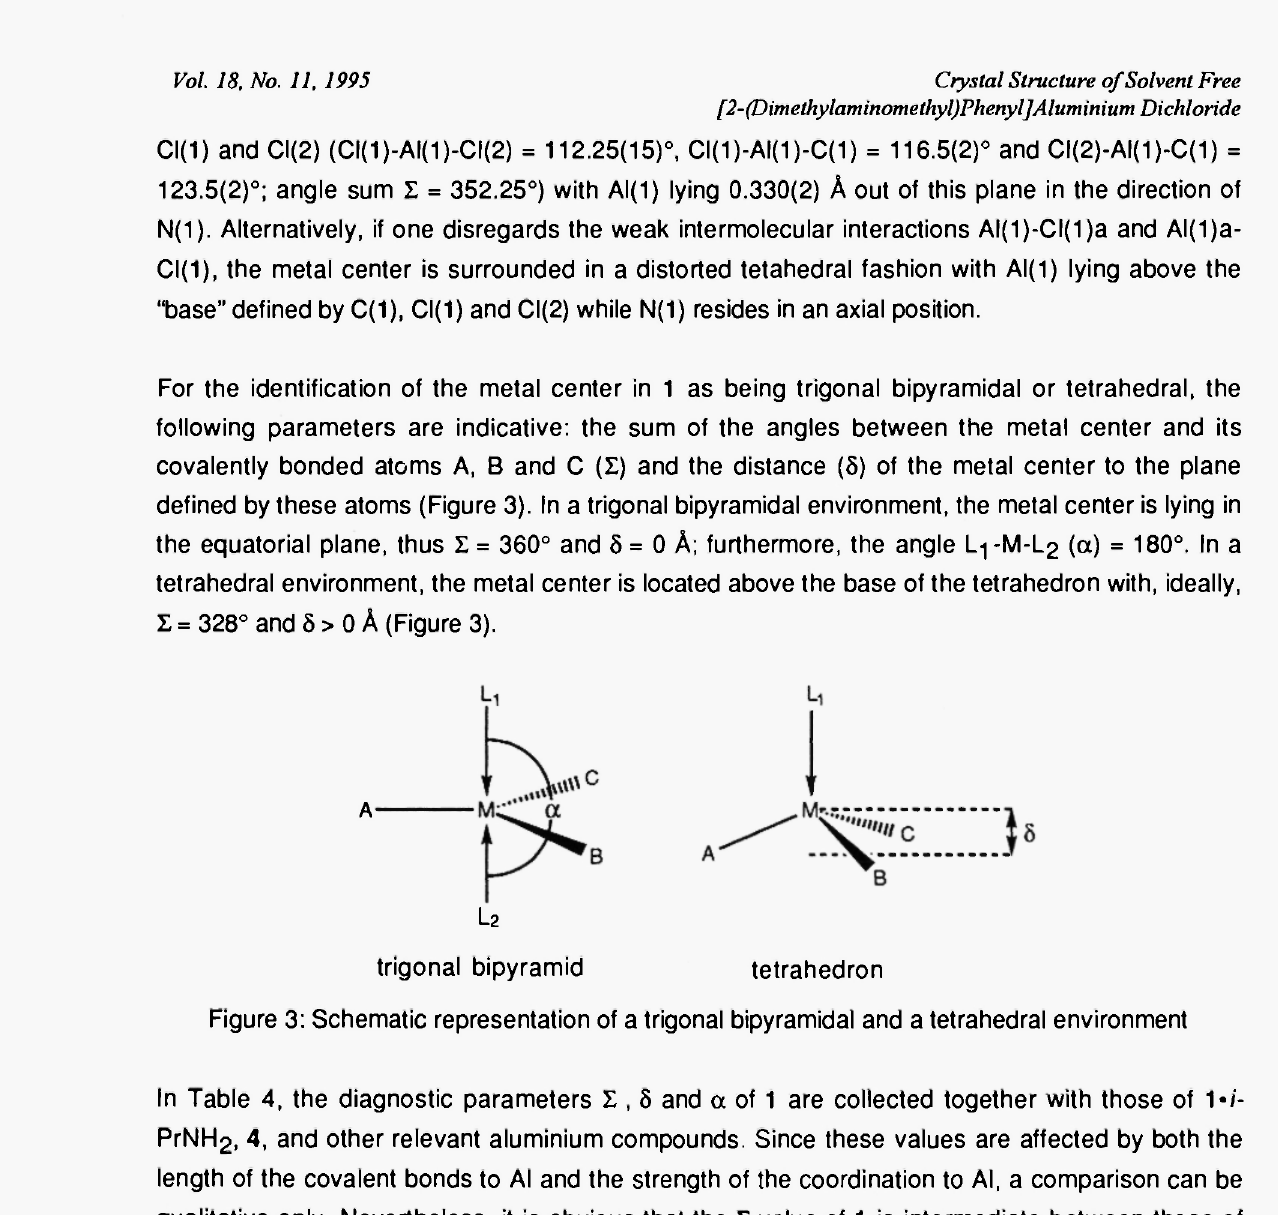
Figure 3: Schematic representation of a trigonal bipyramidal and a tetrahedral